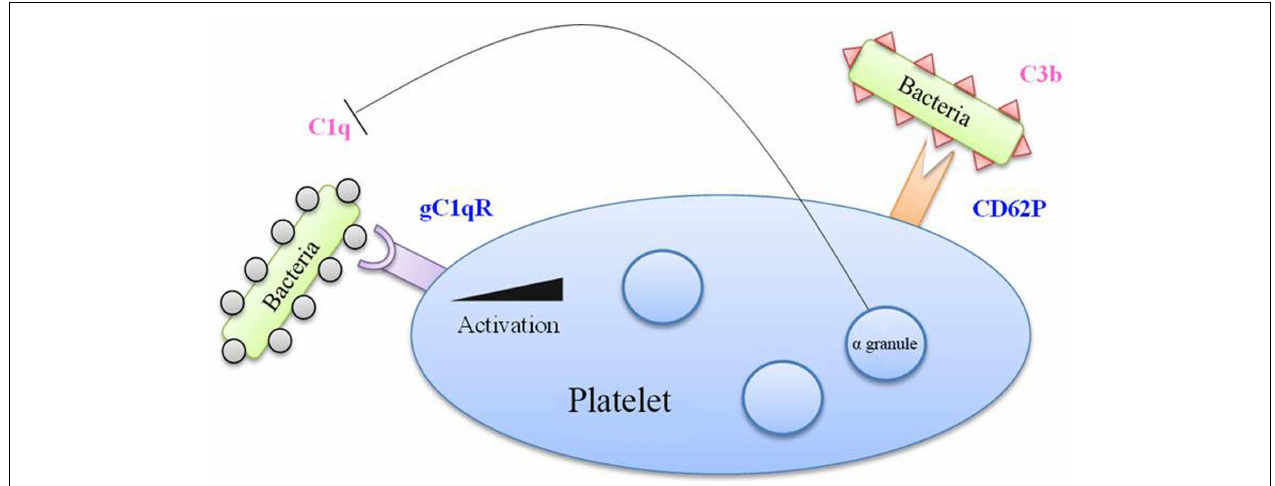
CD62P marker, expressed by activated platelets, is able to recognize the C3b factor. Besides, alpha-granules contain a C1q inhibitor, which limits the interaction between C1q and